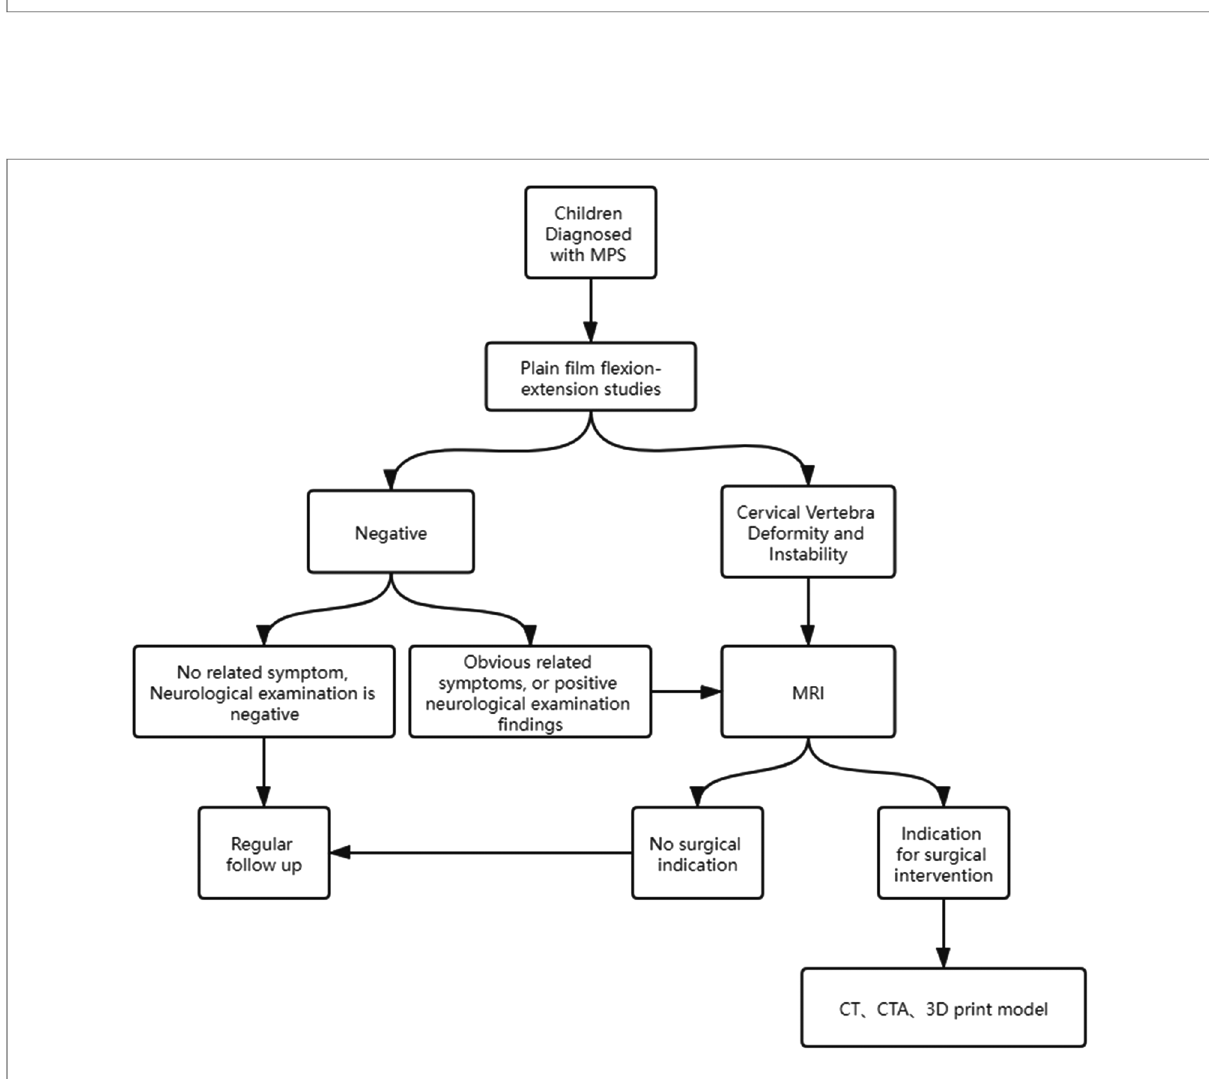
FIGURE 2 Screening procedure for children diagnosed with